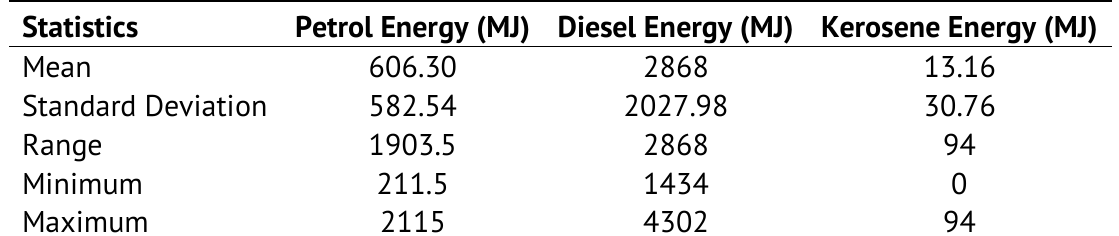
Descriptive statistics on daily liquid fuel energy consumed